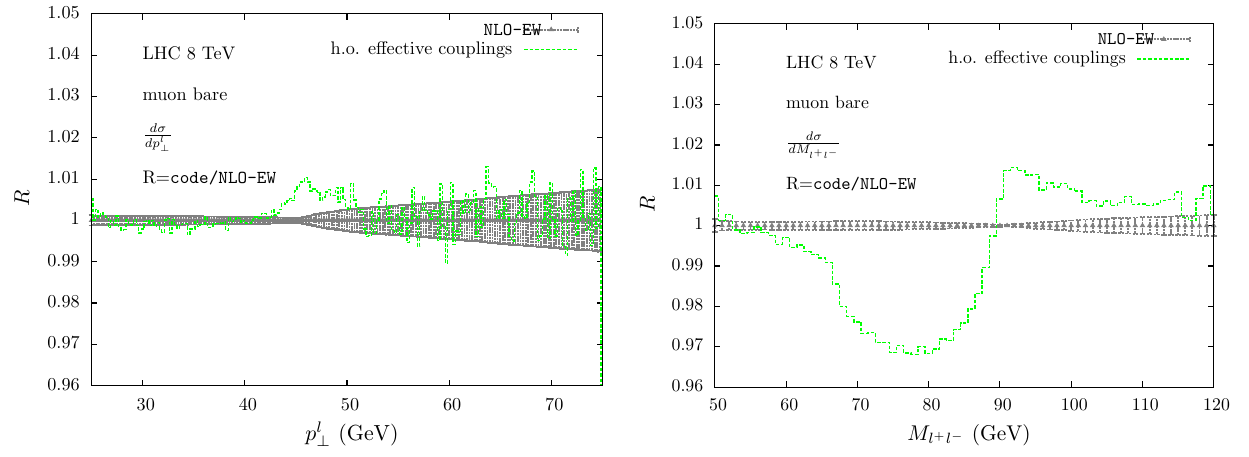
Fig. 29 Relativeeffectofhigher-order( O (α 2 ) andhigher)EWcorrec- tions in pp → μ + μ − + X due to the inclusion of universal corrections via effective couplings. Shown are the lepton transverse momentum